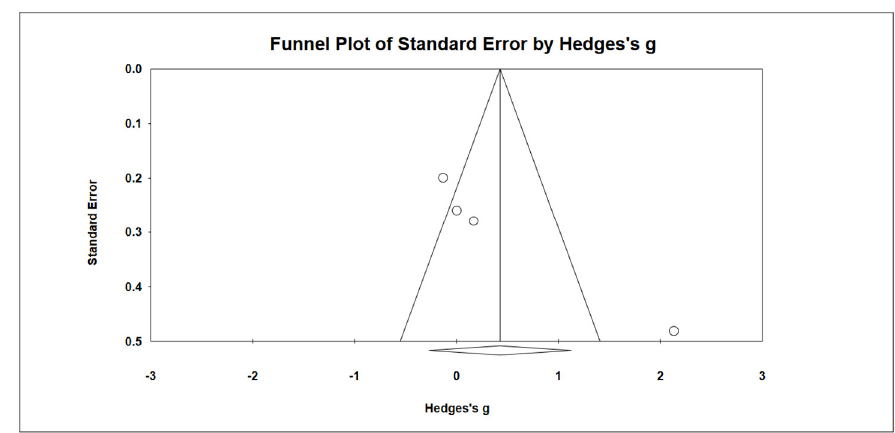
Figure 9. Funnel plot for child’s mindfulness.